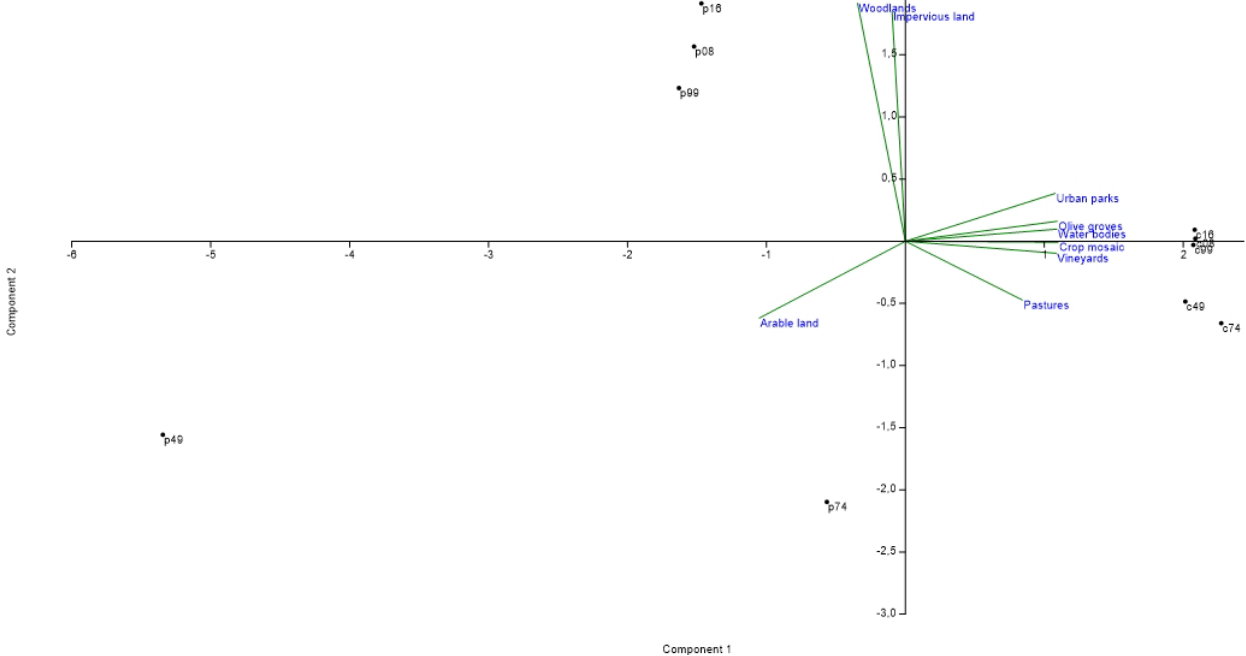
Figure 4. Results of a Principal Component Analysis run on the matrix including percent rates of change in land ‐ use and per ‐ capita land ‐ use in Rome, 1949–2016.